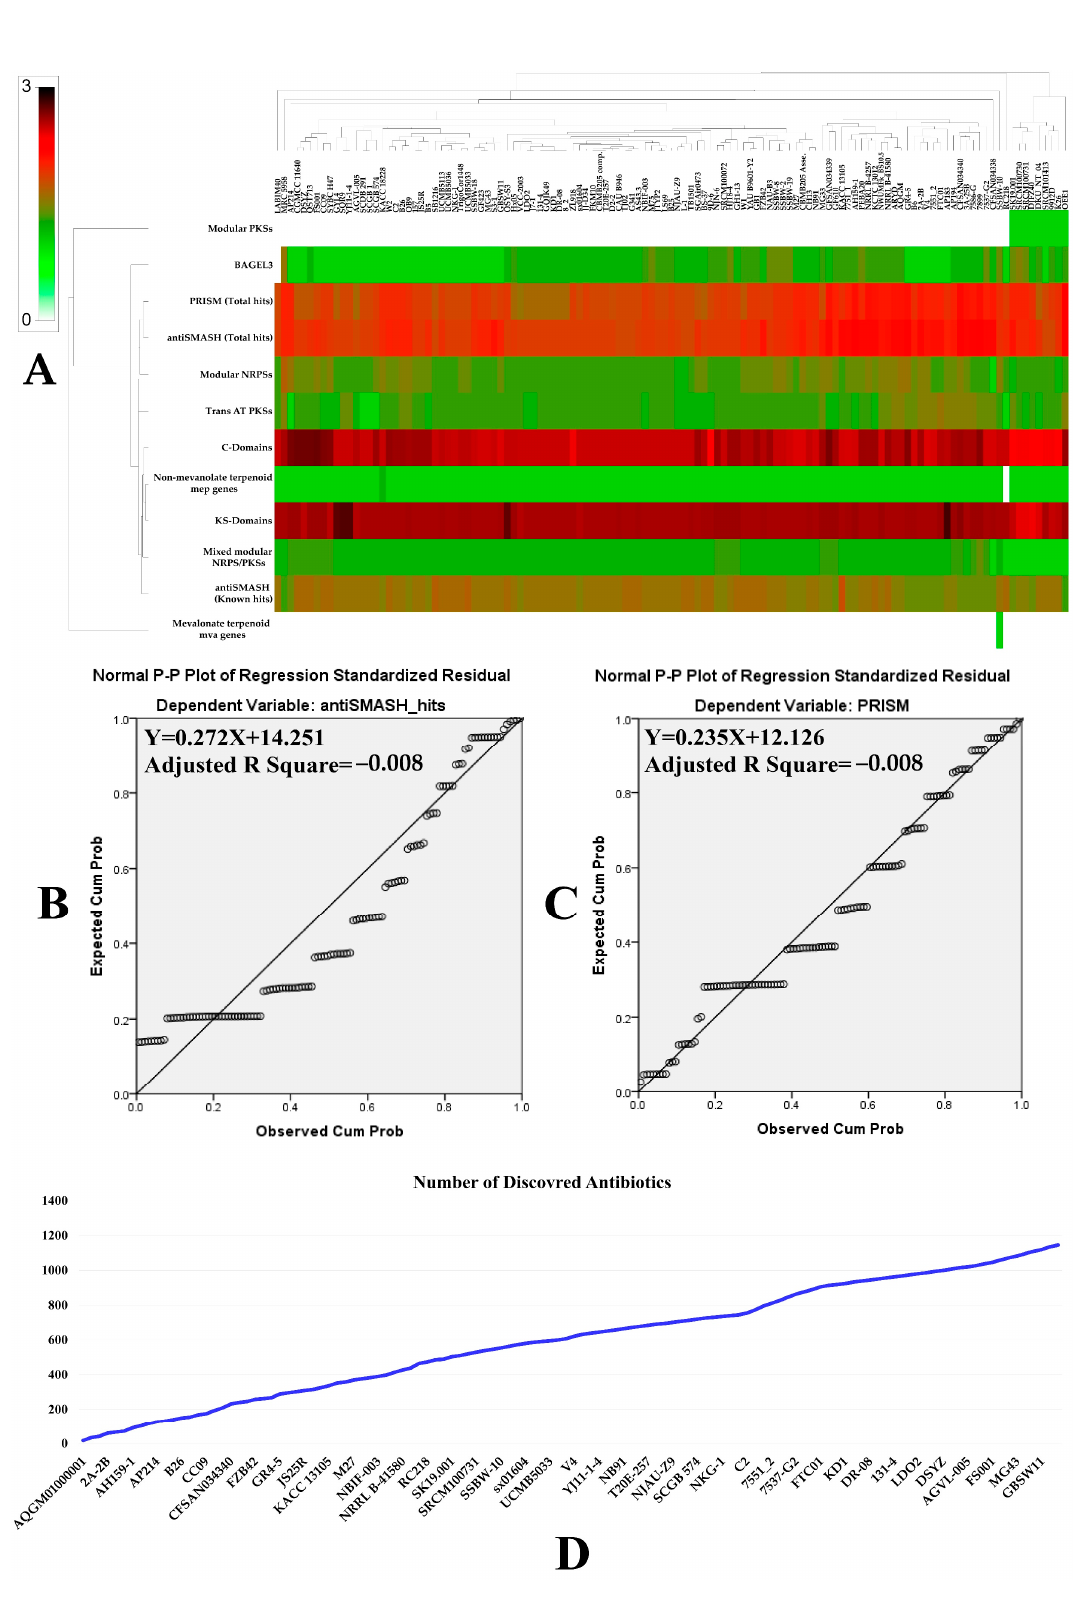
Figure 4. Secondary metabolite arsenal of B. velezensis isolates and its relationship to genome size and accessory genomes. ( A ) Genome mining of secondary metabolite clusters illustrated by a heat map; ( B ) Linear relationship between antiSMASH total hits and genome sizes (statistically non-significant); ( C ) Linear relationship between PRISM total hits and genome sizes (statistically non-significant); ( D ). Evolution of the number of discovered secondary metabolites in relation to the number of genomes sequenced.